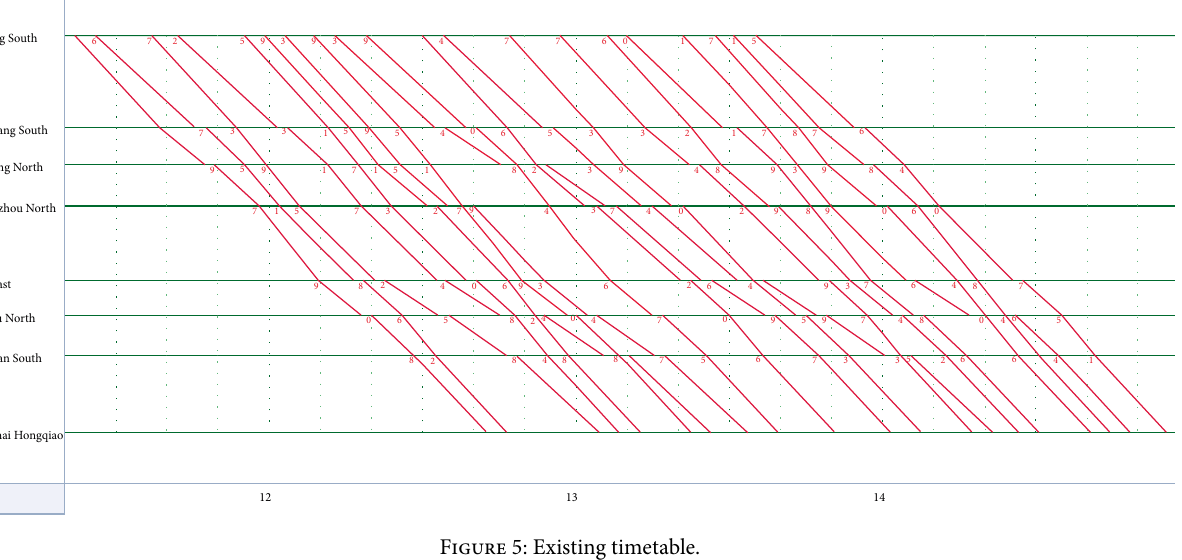
Figure 5: Existing timetable.